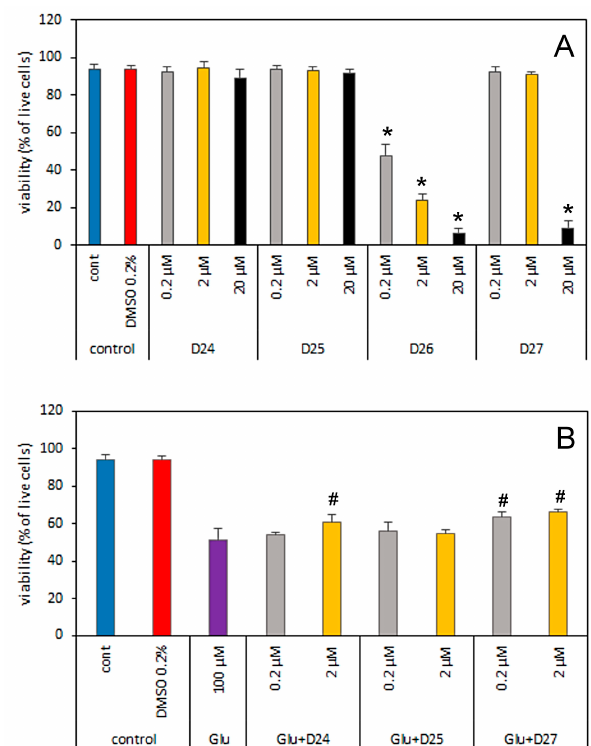
Figure 4. The influence of dendrimers and glutamate on cerebellar granule cells’ (CGC) viability. ( A ) The cells were incubated for 30 min. in Locke medium in the presence of 0.2, 2 and 20 µM D24–D27 and viable cells were measured 24 h later. ( B ) cerebral granule cells were treated with 0.2 or 2 µM of D24, D25 or D27 together with 100 µM Glu for 30 min. in Locke 25 medium. Viable cells were counted after 24 h. D26 was excluded from this experiment based on data presented in Figure 4A where its high toxicity is shown. The results are presented as means ± E.S.Ds from 6 repetition performed using independently prepared cultures. * - Effect of the tested compound is significantly different from the 0.2% DMSO (solvent of dendrimers). # Effect of the tested compound is significantly different from that of the 100 µM Glu ( p < 0.05, one-way analysis of variance (ANOVA)).